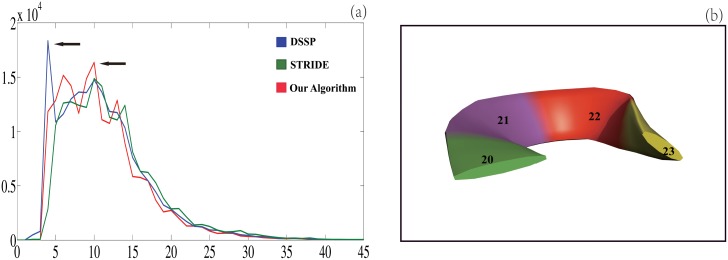
The distributions of the lengths of the α-helices from our algorithm, dssp and stride (a), and an example of 4-residue α-helix by dssp(b).The x-axis in (a) is the helix length while the y-axis is the number of the helices with that particular length. The two arrows point to the most frequently appeared helices assigned by dssp and by both our algorithm and stride. The right figure (b) depicts a dssp-assigned 4-residue α-helix in a protein (pdbid 1CC5) that is not assigned to a helix by our algorithm.